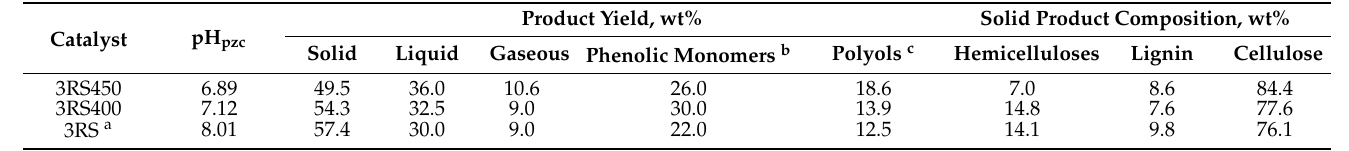
Table 9. The effect of pH pzc value of the Ru catalysts on the yield and composition of products of spruce wood RCF at 225 ◦ C for 3